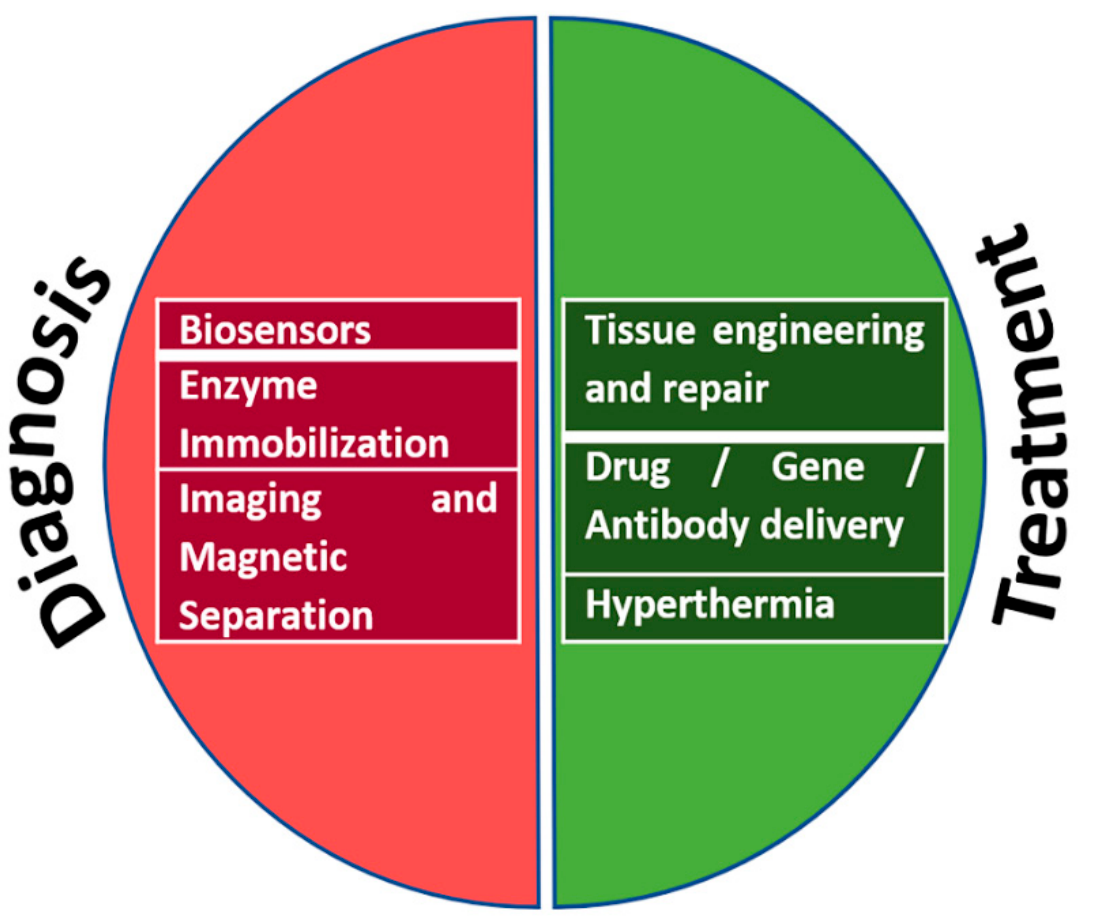
Figure 3. Diagnosis and treatment options provided by MNPs.